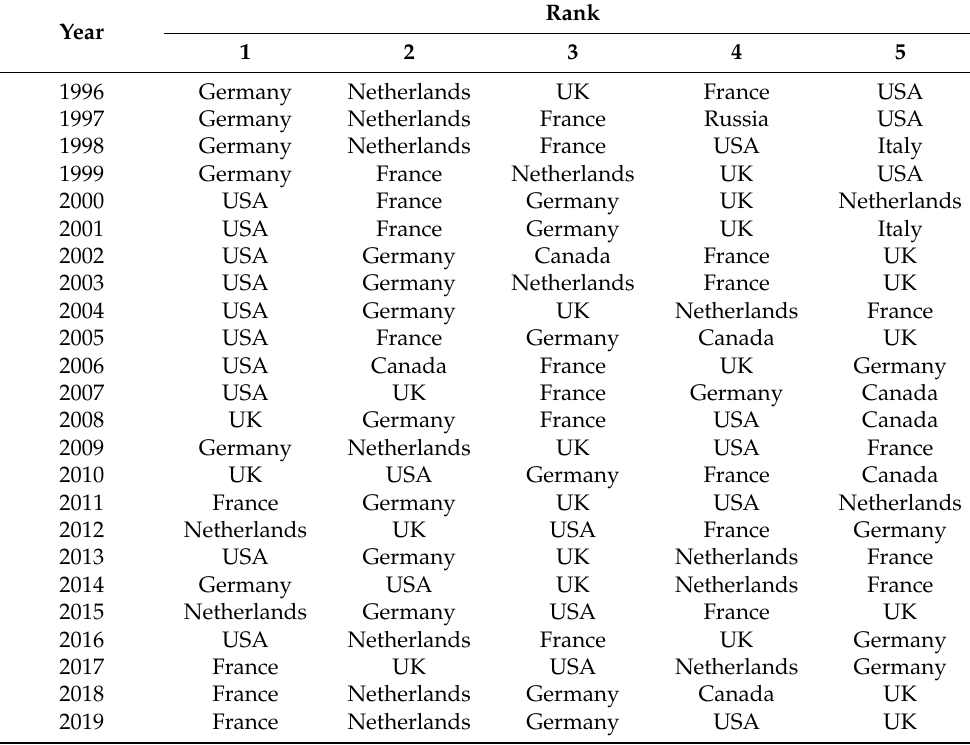
Table A3. The top 5 countries in eigenvector